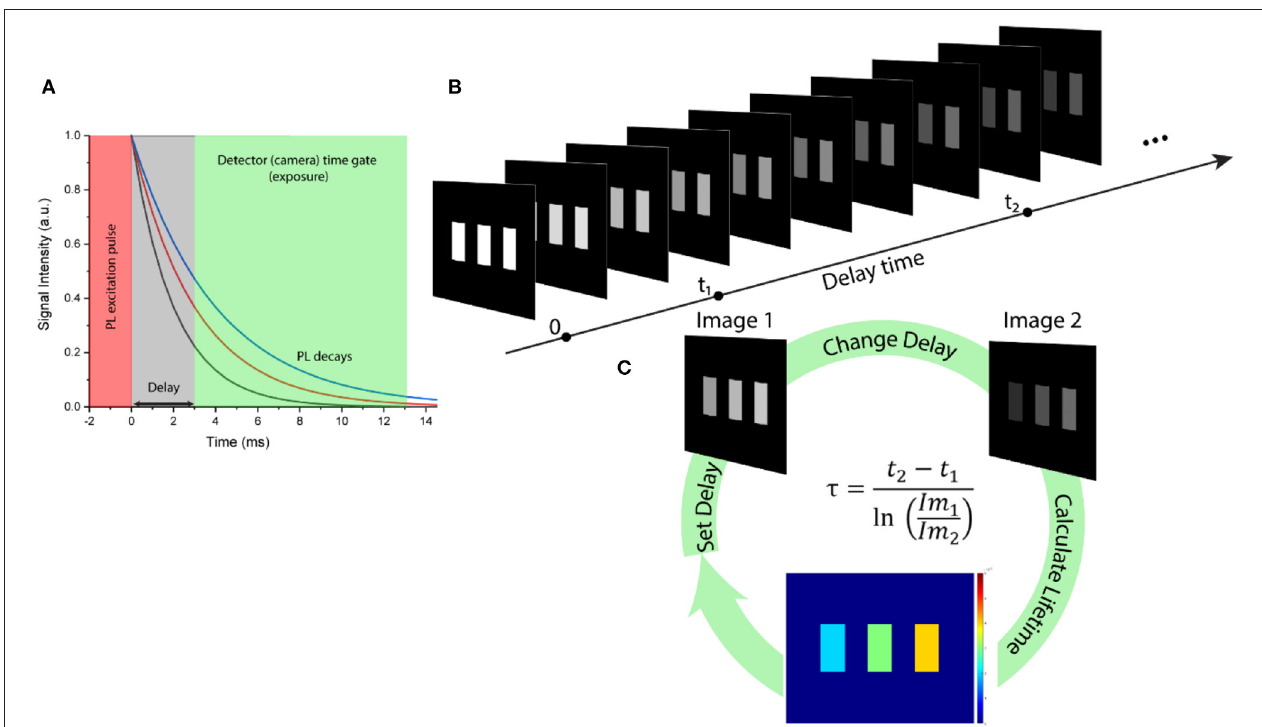
FIGURE 1 | (A) Schematic representation of the PL signal selection using time-domain filtering. (B) Stack of time-gated PL images acquired with gradually increased delay time. (C) Three-step rapid lifetime determination scheme for real-time anti-counterfeiting imaging, where t 1 and t 2 are delay times for acquiring Image 1 and Image 2 with Im 1 and Im 2 intensity values, respectively, and τ is PL lifetime calculated for each